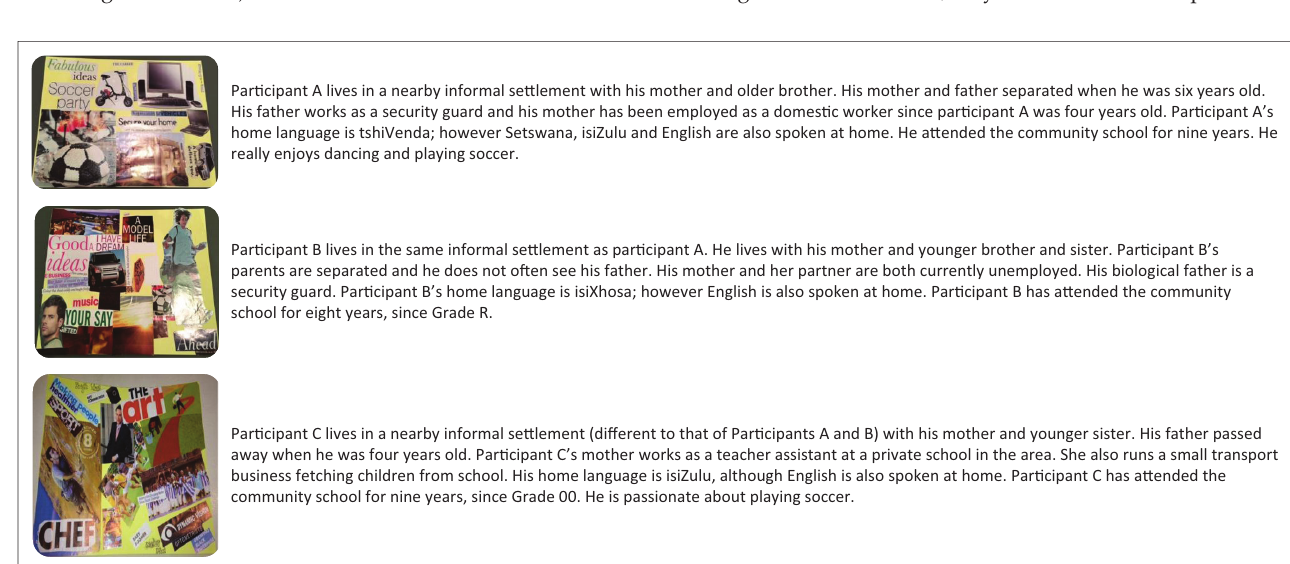
FIGURE 2: Participants’ background